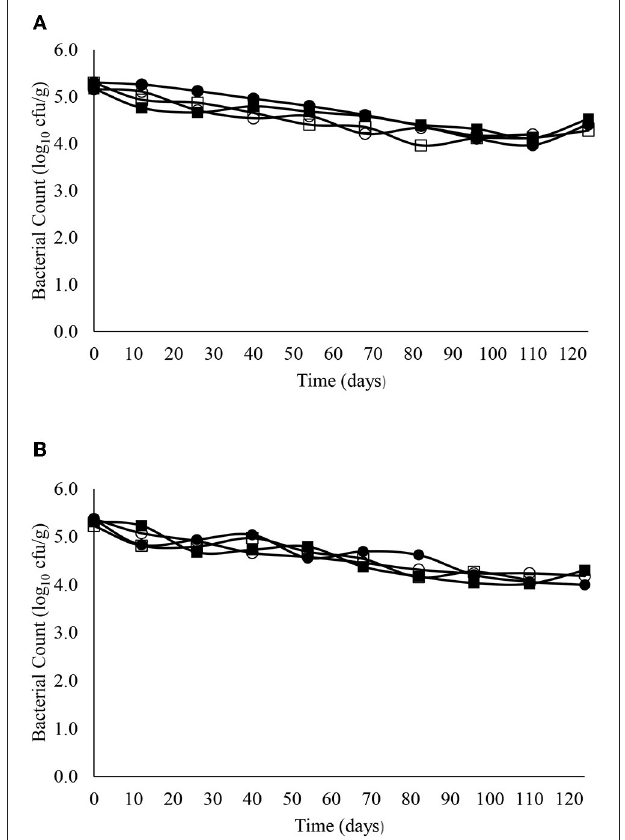
FIGURE 6 | The reduction in E. faecalis over time in sandy (A) and clay (B) soils including with slurry at 4 ◦ C ( (cid:4) ), digestate at 4 ◦ C ( (cid:3) ), slurry at 14 ◦ C ( • ) and digestate at 14 ◦ C (o).